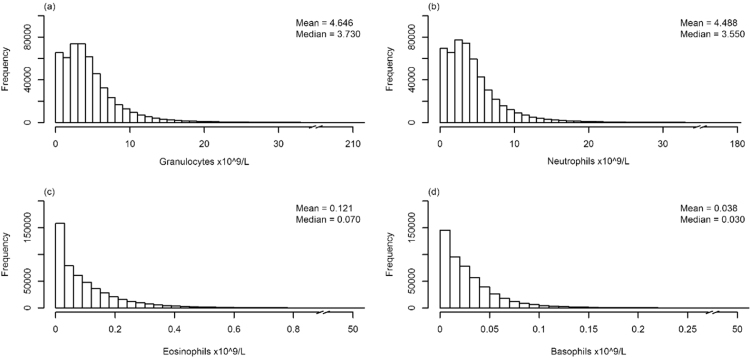
Distribution of cell count results for total granulocytes and individual differentials. Histograms of 508646 results for (A) granulocytes (x 109 cells/L) (minimum = 0; maximum = 213.42, median = 3.73; mean = 4.65; standard deviation (SD) = 4.31; (B) neutrophils (x 109 cells/L) (minimum = 0; maximum = 180.58, median = 3.55; mean = 4.49; SD = 4.21); (c) eosinophils (x 109 cells/L) (minimum = 0; maximum = 53.69, median = 0.07; mean = 0.12; SD = 0.26); (d) basophils (x 109 cells/L) (minimum = 0; maximum = 51.43, median = 0.03; mean = 0.04; SD = 0.15).